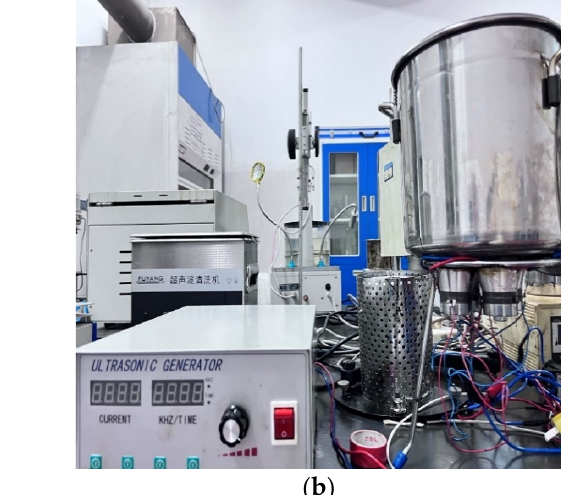
( b ) Figure 12. Sound field intensity distribution at 40KHz frequency. ( a ) Top view ( b ) Main view 5.2. Viscosity Test and Result Analysis The 5% nano-SiO 2 modified asphalt prepared by high-speed shear was subjected to ultrasonic disposal, and the ultrasonic frequency 28 K Hz, 40 K Hz, 52 K Hz, and ultrasonic temperature 363 K, 383 K, 403 K, 423 K were changed to record the viscosity change of the ultrasonic treatment process, and the relationship curve of the rate of viscosity change of the modified asphalt with temperature and frequency under the action of ultrasonic was obtained. The test results are shown in Figure 13. In the temperature range of 363 to 383 K, the viscosity of nanoasphalt shows a significant decrease with the increase of tempera- ture. This is because as the temperature increases, the internal structure of asphalt is changed by ultrasonic cavitation, which breaks the long molecular chains of asphalt and